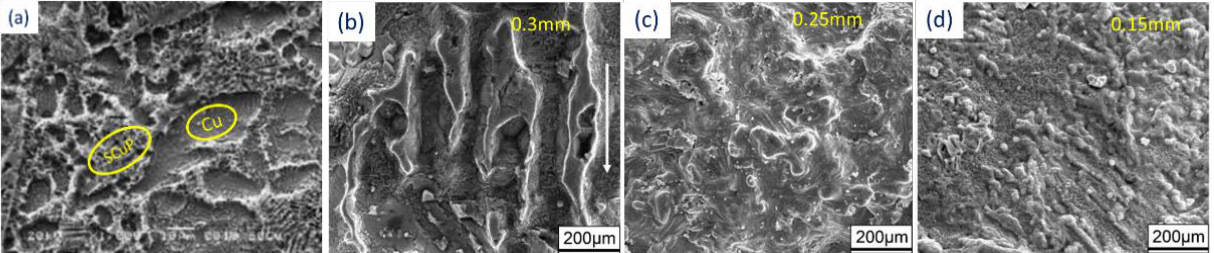
Figure 5. Scanning electron microscopy images of sintered samples prepared with ( a ) Cu-SCuP [105] and ( b – d ) W-Cu [106].